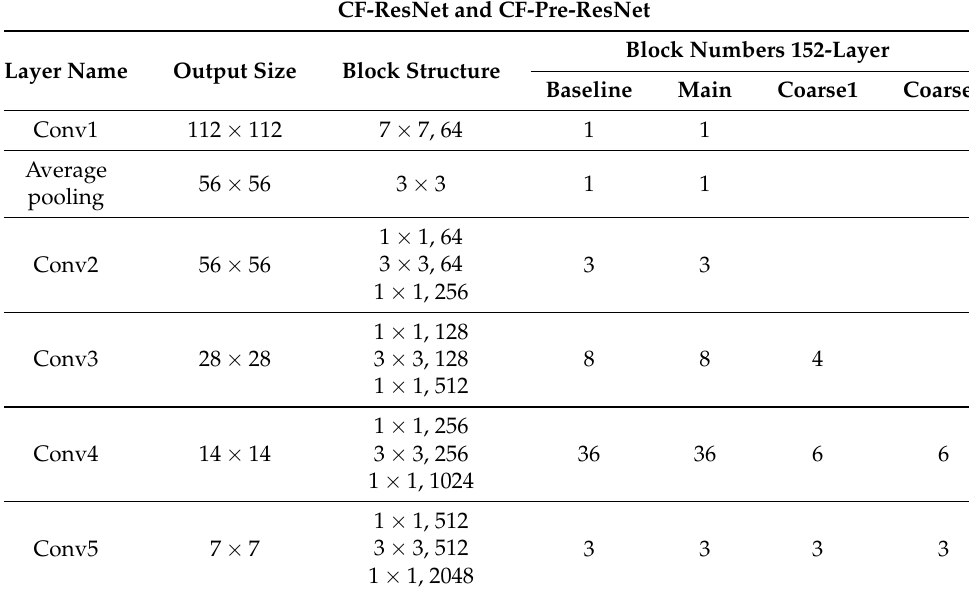
Table 6. Structure of the CF-ResNet and CF-Pre-ResNet model for ILSVRC 2012